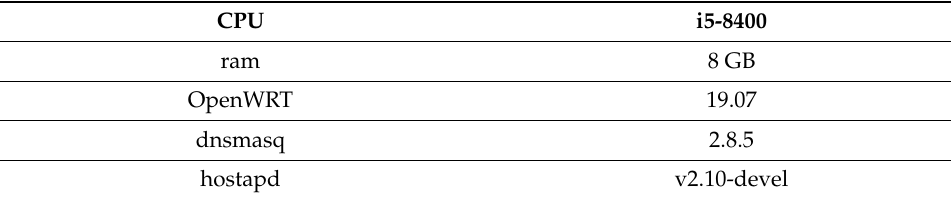
Figure 8. DESEND+ in a real environment with the topology. Table 7. Gateway information.